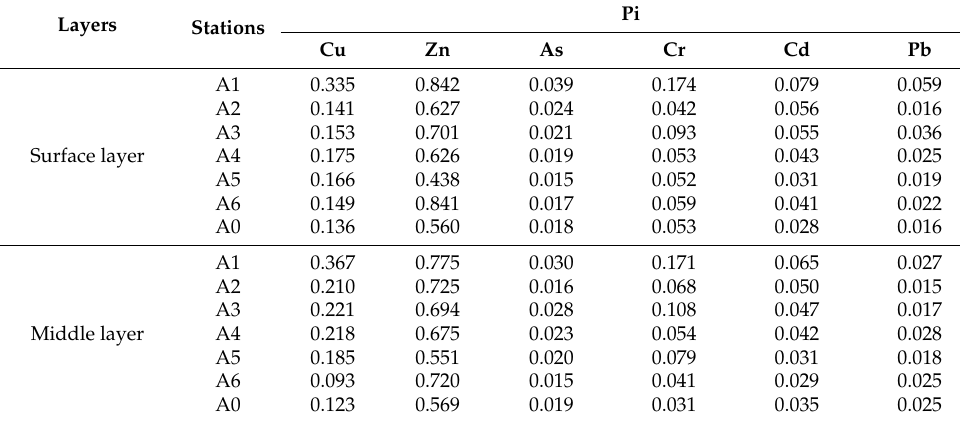
Table 4. Single factor pollution index (SFI) of heavy metals in oysters. Layers